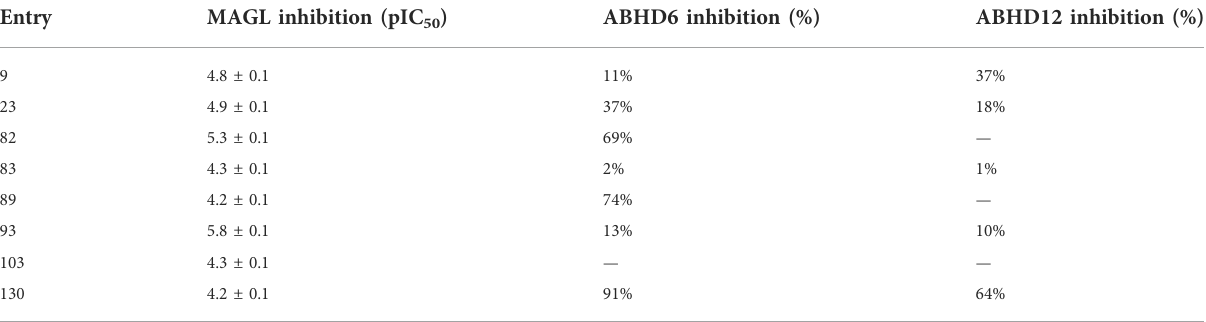
TABLE 1 Inhibition of recombinant human MAGL, ABHD6, and ABHD12 was determined by indicated assays. Data of pIC 50 represent average values ±SEM, n = 4 per group. Inhibitory activities of the compounds against ABHD6 and ABHD12 were determined at 100